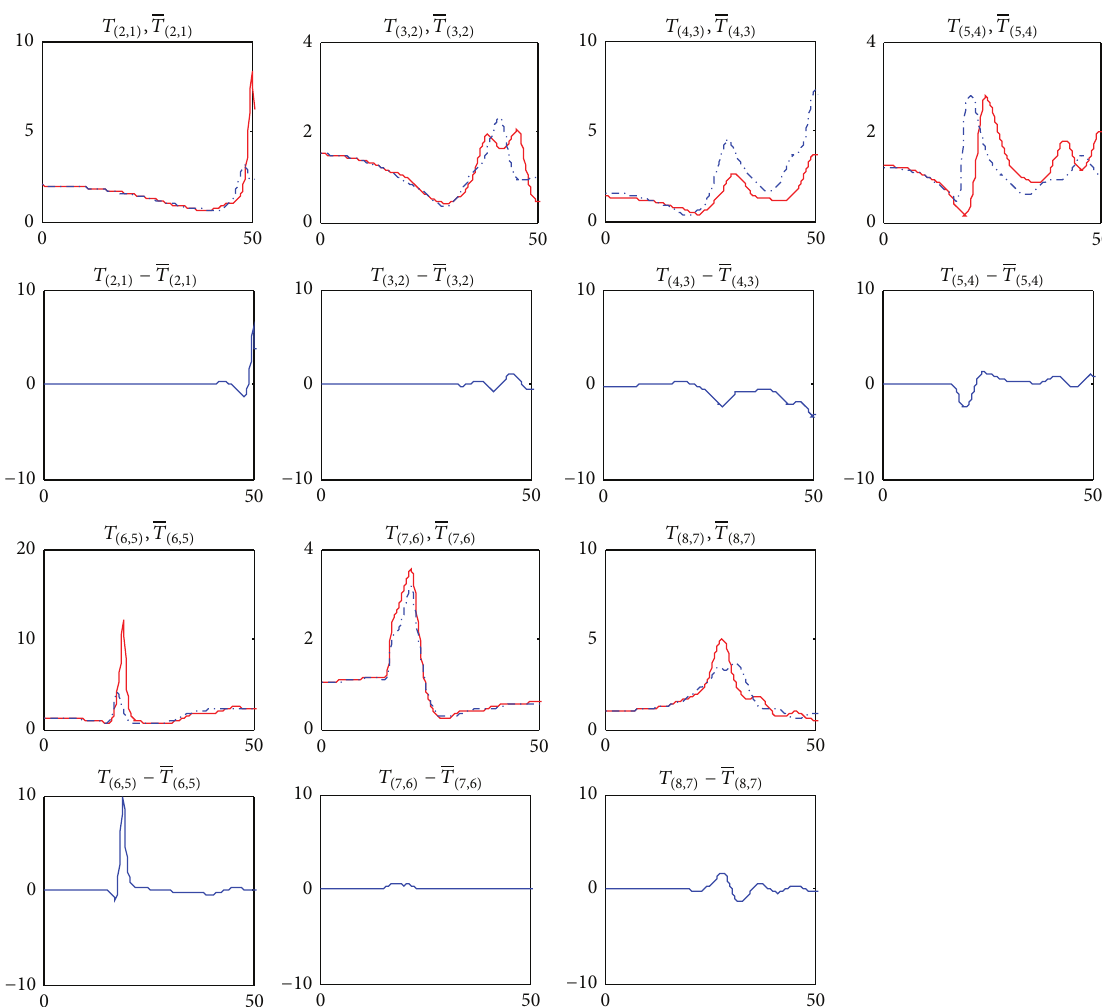
Figure 2: TFs of the system with linear local variation before and after the variation and their difference versus frequency (Hz): blue— 𝑇 (𝑖+ 1 ,𝑖) , red— 𝑇 (𝑖+ 1 ,𝑖) .